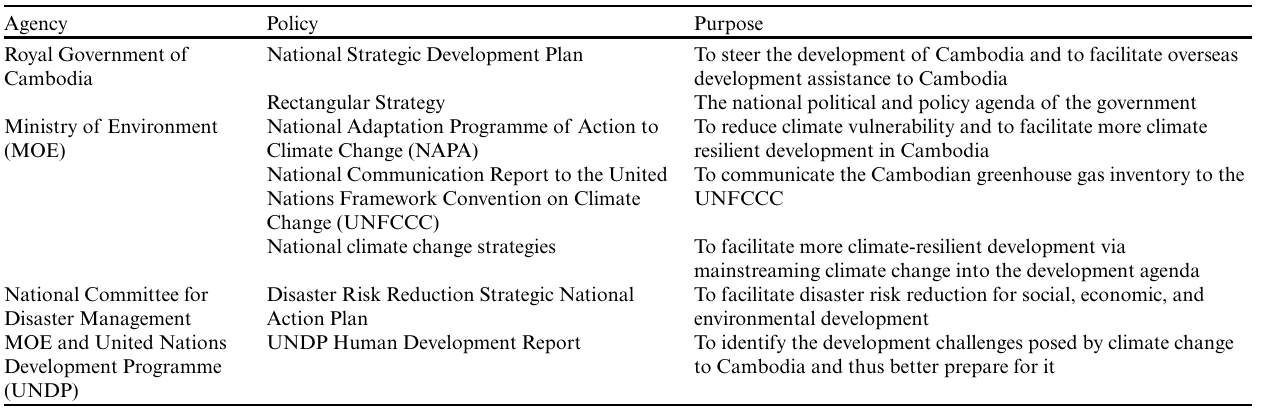
Table 1 . Key policies, strategies, and reports that have influenced climate change adaptation in Cambodia.